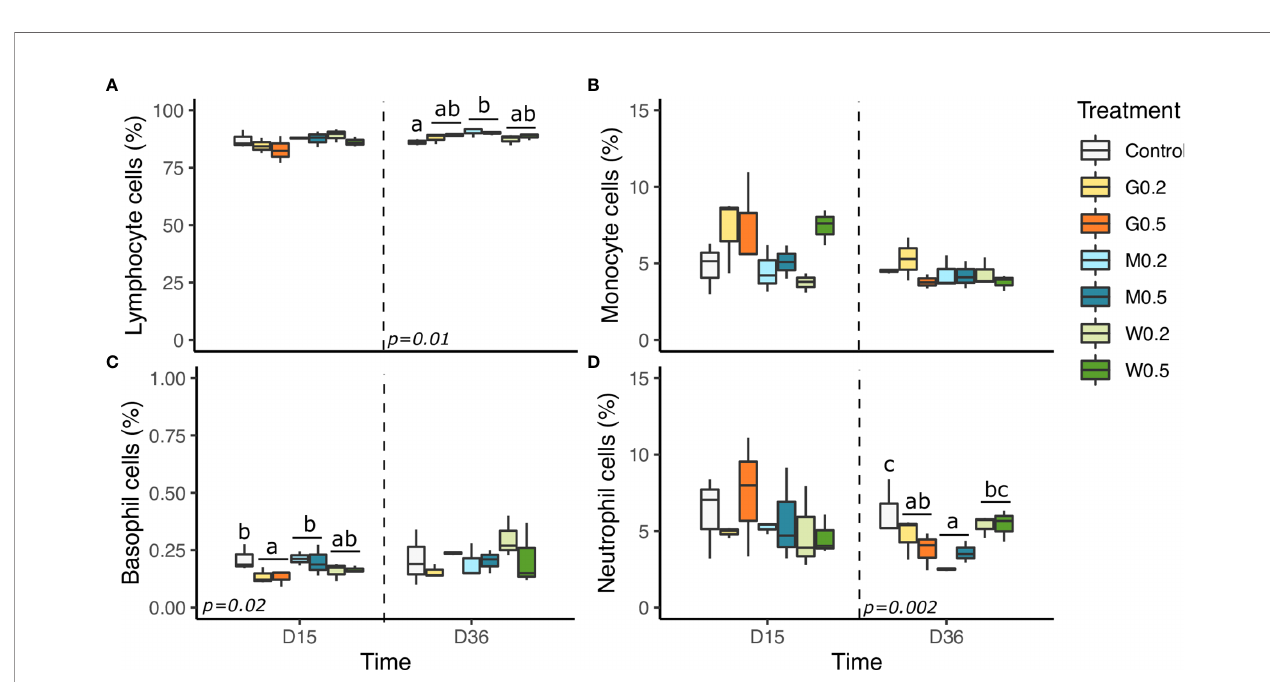
FIGURE 2 | Effects of dietary beta glucan administration on blood leukocyte cell proportions of fi sh sampled during the nutrient test on D15 and D36. (A) Lymphocyte + thrombocyte cells proportions. (B) Monocyte cells proportion. (C) Neutrophil cells proportion and (D) Basophil cells proportion in total blood leukocyte cells population. Values are expressed as mean ± SD of 18 fi sh/diet/day on D15, D36. Statistical differences, highlighted by letters, are indicated for glucan concentrations in front of 0, 0.2, and 0.5% next to the corresponding plot, for glucan type by letter above the horizontal bar grouping the two doses of the same glucan, for glucan type × concentrations interactions above each box. P values are shown at the bottom of each graph at a given time point (D15, D36, or D39).